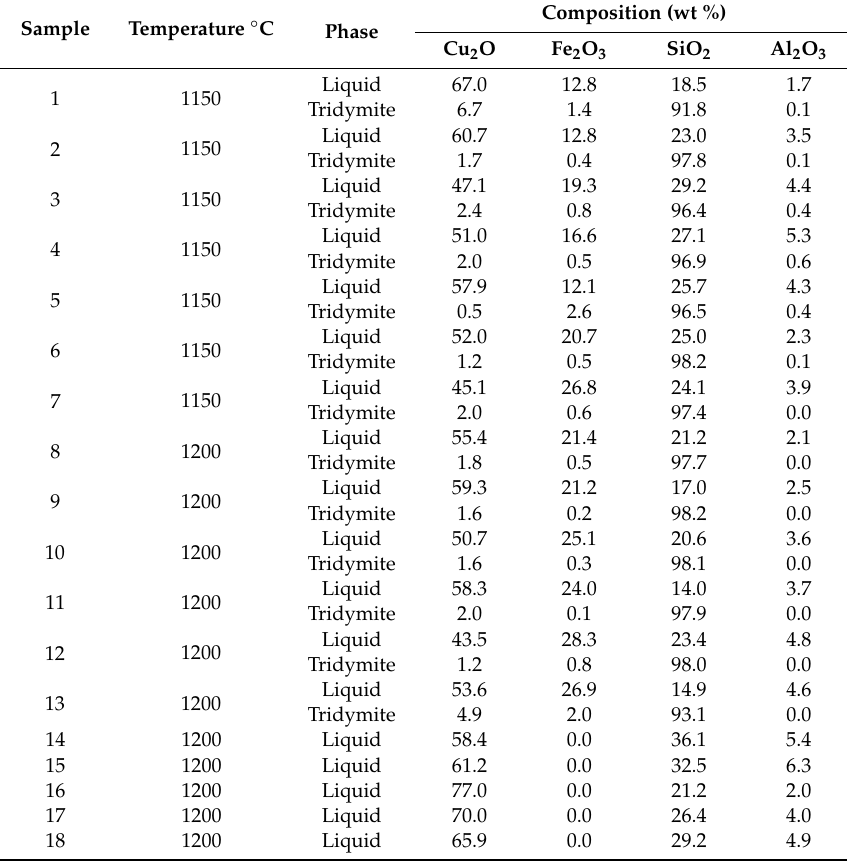
Table 2. Phase compositions determined experimentally for the Cu 2 O–Fe 2 O 3 –SiO 2 –Al 2 O 3 system in equilibrium with metallic copper at 1150 ◦ C and 1200 ◦